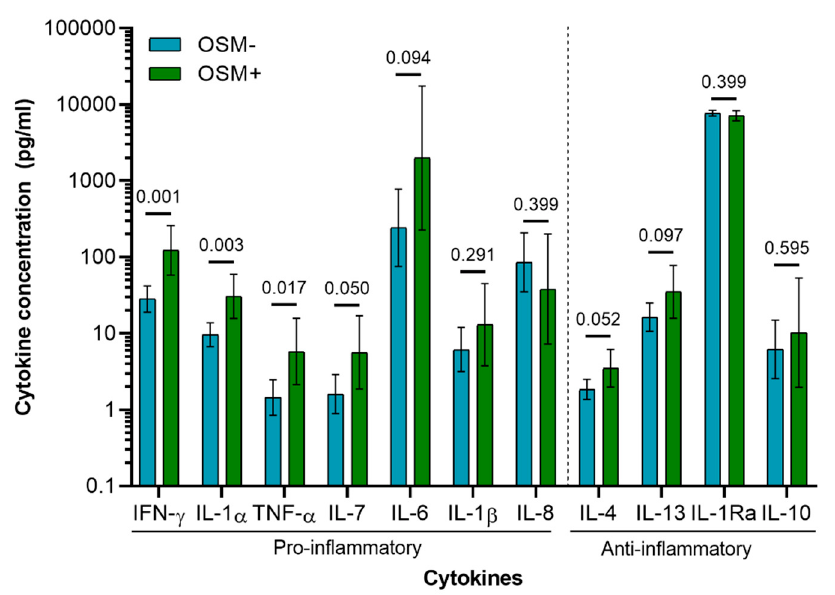
Figure 5. Cytokine concentration in synovial fluid of OA patients ( n = 27; OSM − = 21; OSM+ = 6). Concentration values were back transformed to the original scale as described previously [36]. Values presented are the estimated means and 95% CI derived from the general linear mixed model, with the p -values of the Wald tests performed between patient groups (OSM − and OSM+) for each cytokine.